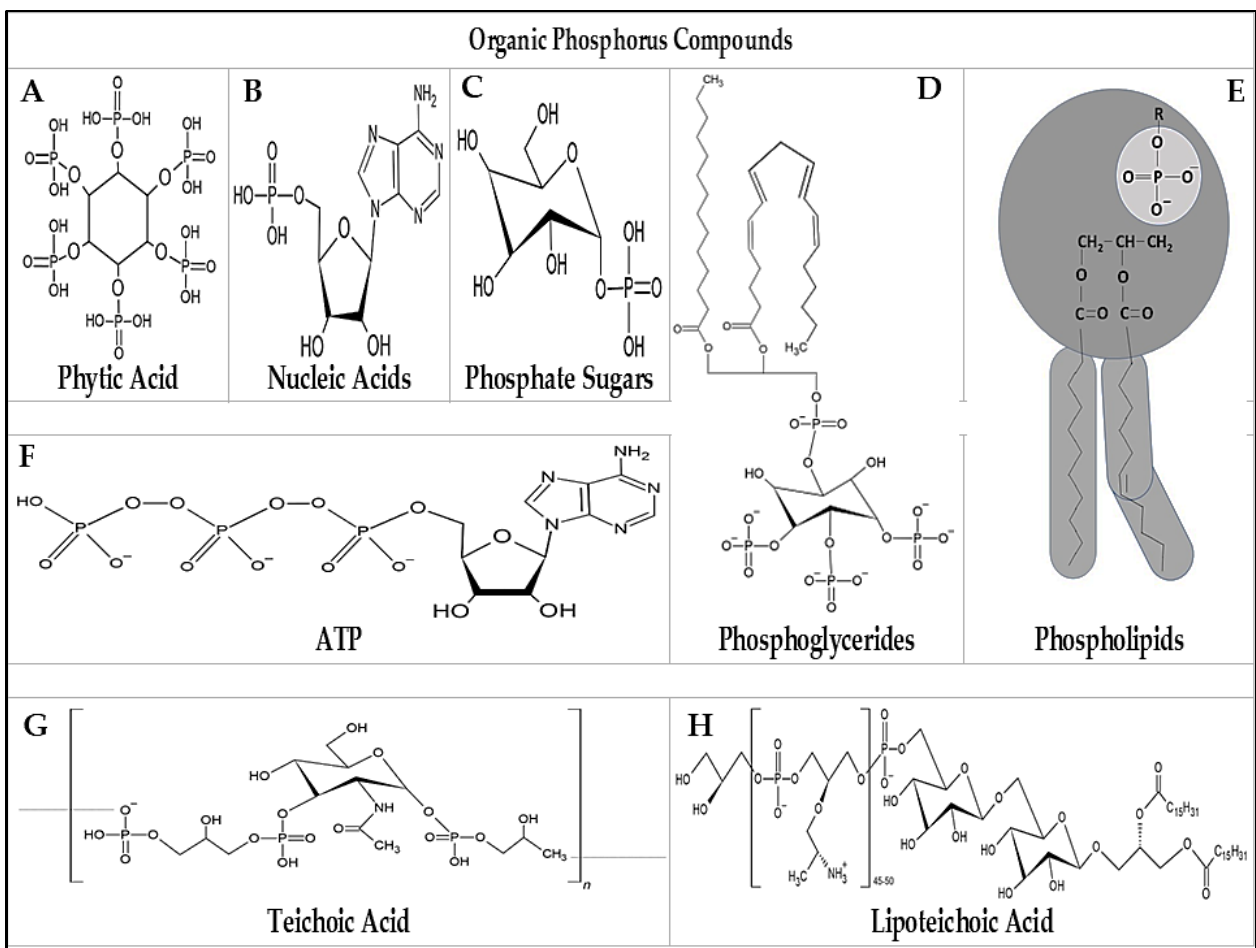
Figure 2. Organic phosphate compounds in the soil. ( A) phytic acid, ( B ) adenine nucleotide, ( C ) galactose 1-phosphate, ( D ) phosphatidyl inositol 3,4,5-triphosphate, ( E ) phospholipid, ( F ) adenosine 3-phosphate, ( G ) teichoic acid, ( H ) lipoteichoic acid.